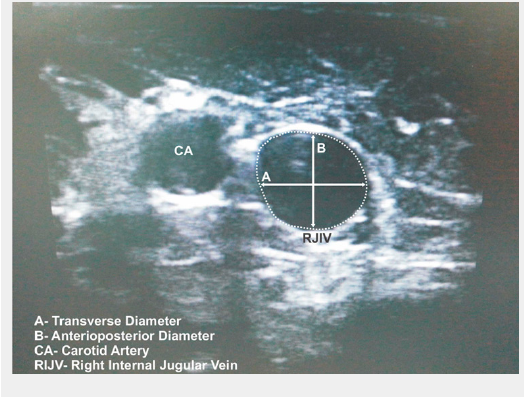
A still image of the RIJV, diameters and cross-sectional